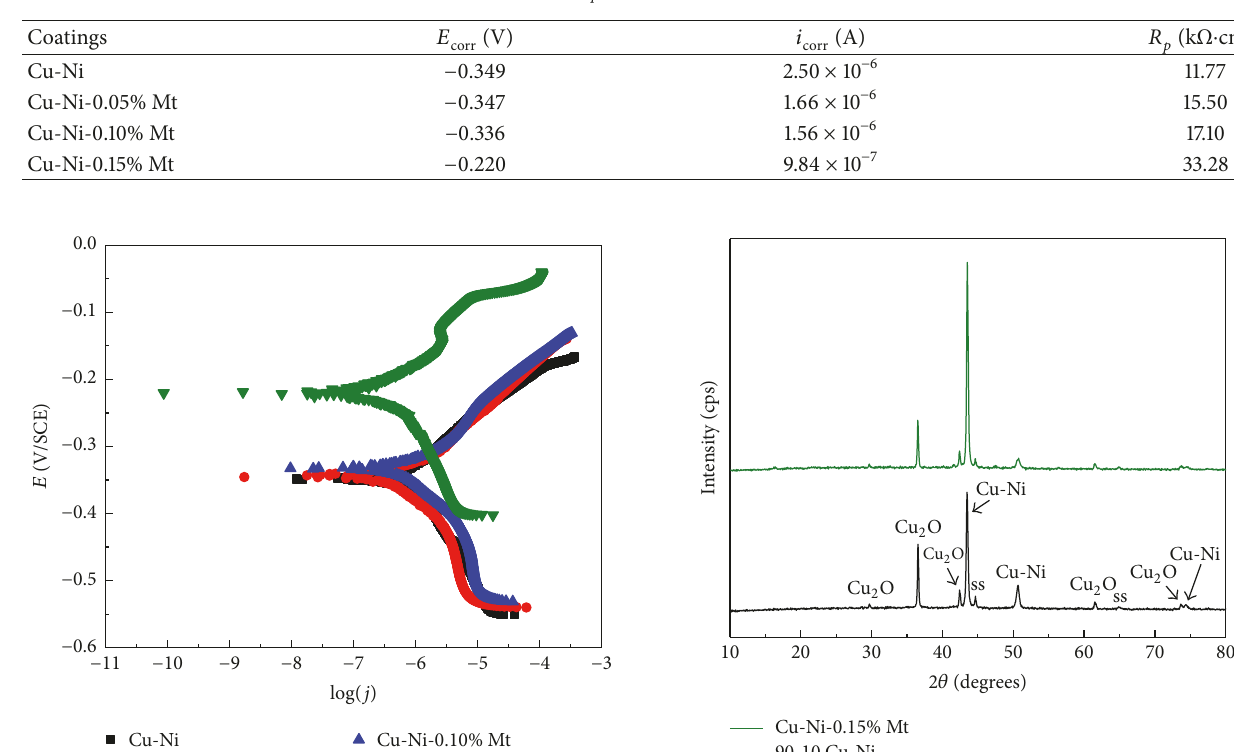
Table 5: 𝐸 corr , 𝑖 corr , and polarization resistance (𝑅 𝑝 ) of the pure 90-10 Cu-Ni and Cu-Ni-Mt composite coatings.